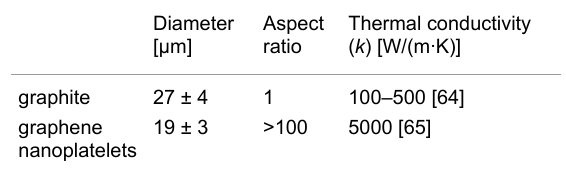
Table 2: Composition and viscosity of two hybrid GNP–graphite com- posites (X and Y) having nearly identical thermal conductivities but dif- ferent viscosities (see also Figure